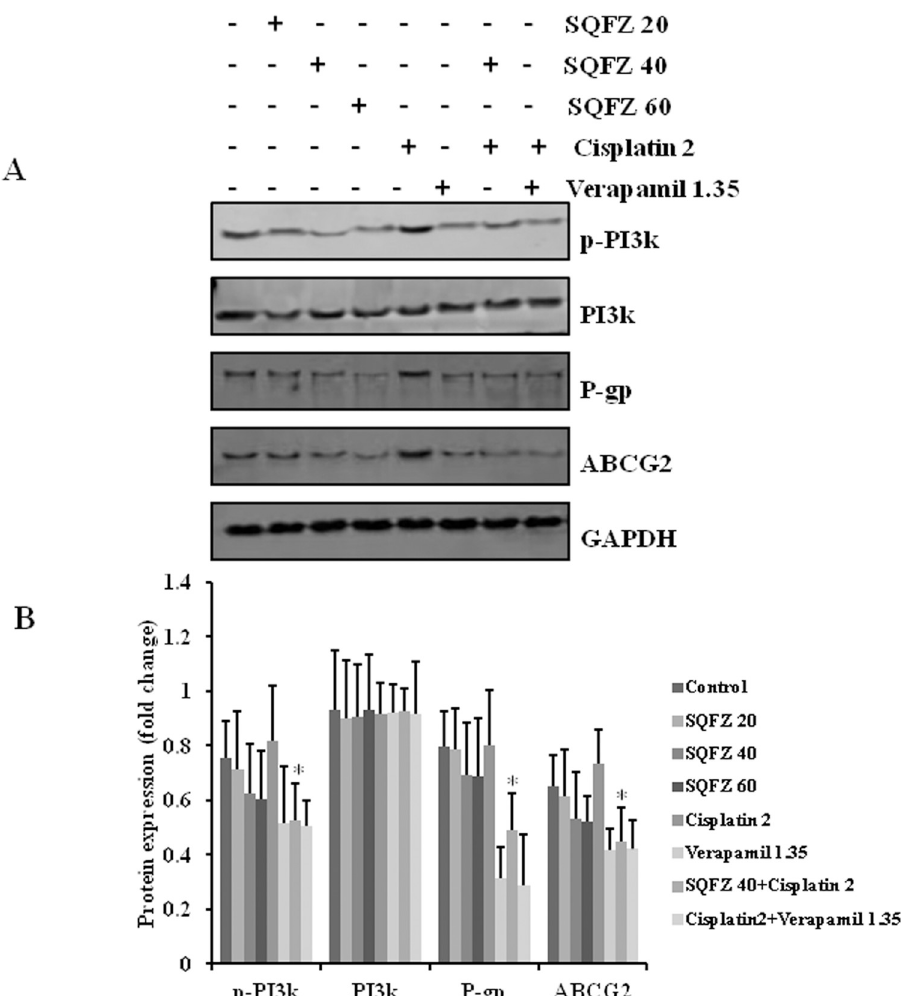
Fig 4. Effects of SQFZ or SQFZ + Cisplatin on the expressions of p-PI3K, PI3K, P-gp, and ABCG2 in MDA-MB- 231/DDP+M2 xenografts. Tumour lysates were analysed for the expressions of p-PI3K, PI3K, P-gp, and ABCG2 with the respective antibodies. The density ratio of detected proteins to GAPDH is shown as relative expression. Values are shown as the means ± SD from three independent experiments. � p < 0.05 as compared to Cisplatin alone.